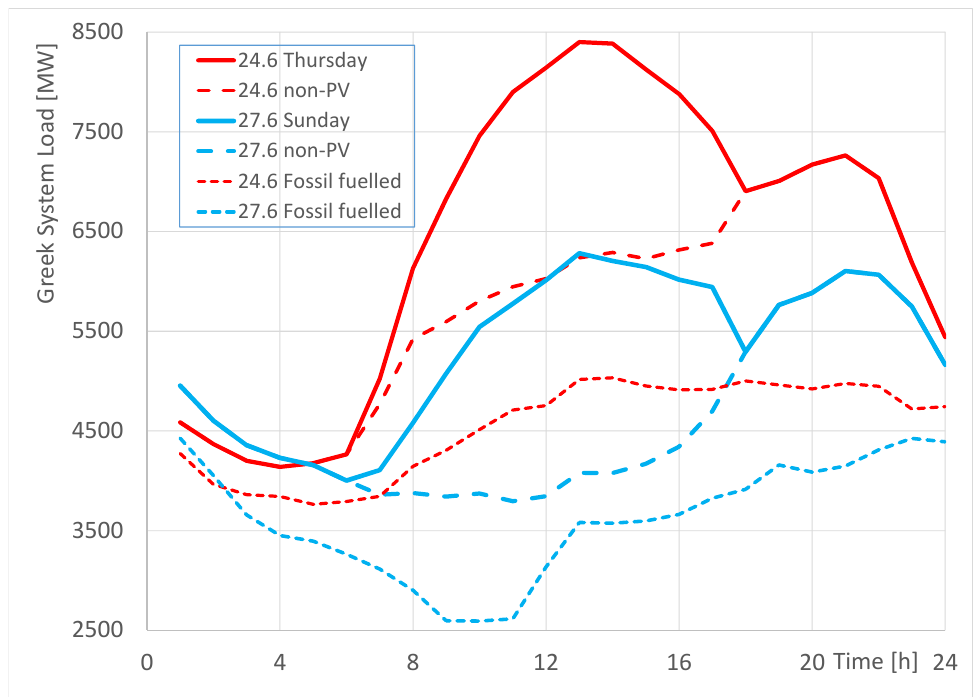
Figure 13. Greek system demand curve during a week-day with high ambient temperatures and clear skies, and a cloudy Sunday in late June 2021 (a heat wave episode recorded). The load curves without the PV contribution and the demand that are covered by fossil fueled power plants are drawn in the same Figure [42].